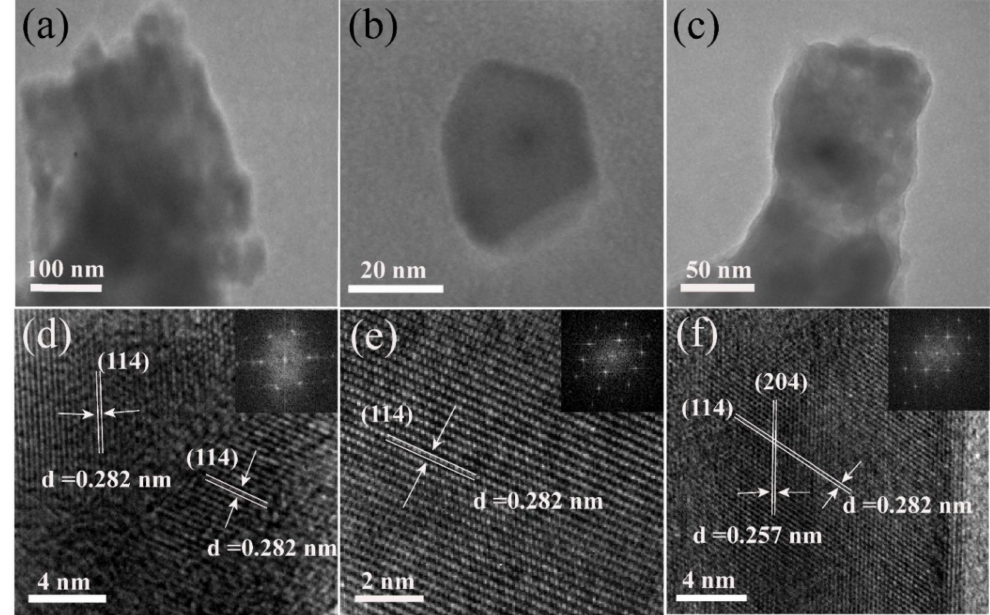
Figure 5. TEM image of MAPbI 3 ( a ) nanoplates, ( b ) nanocubes, and ( c ) nanorods, respectively, and their high-resolution TEM (HRTEM) images ( d – f ). The inset is the corresponding fast Fourier transformation (FFT)